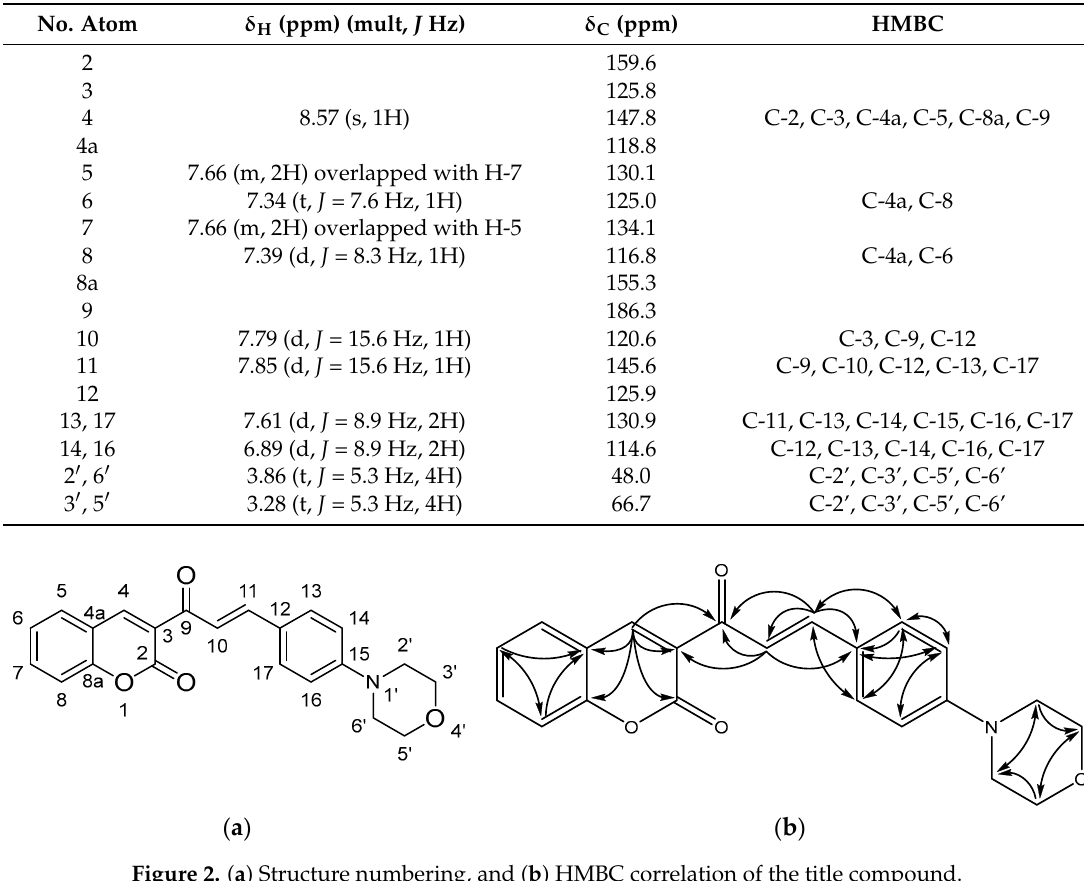
Figure 2. ( a ) Structure numbering, and ( b ) HMBC correlation of the title compound.